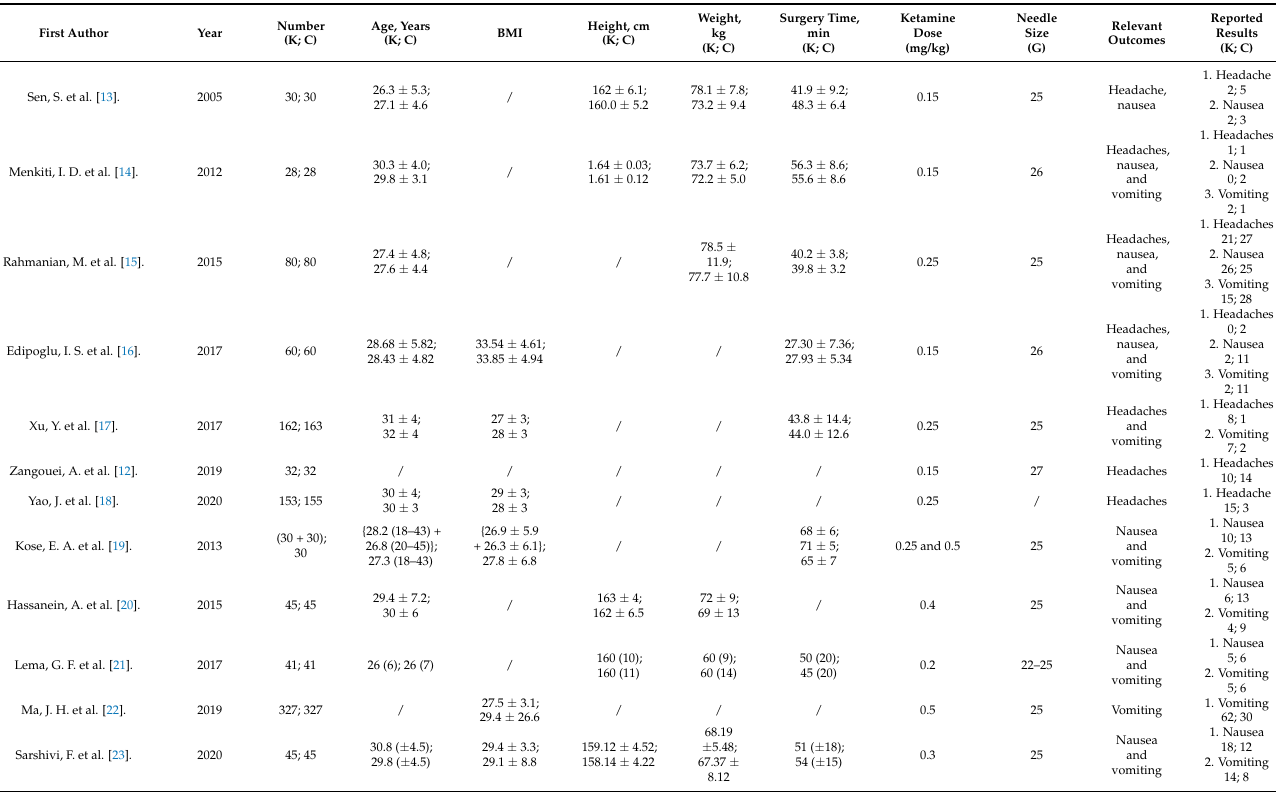
Table 1. Characteristics of the included